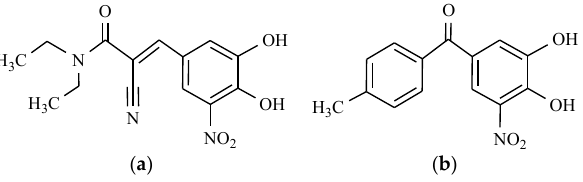
Figure 4. Parkinson’s disease drugs: ( a ) Entacapone; and ( b ) Tolcapone.